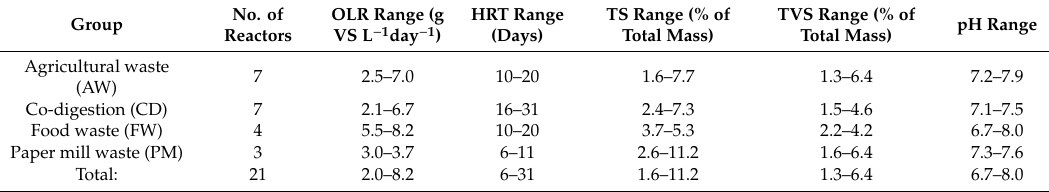
Table 1. Type of feedstocks and operational conditions of sampled laboratory-scale biogas reactors. OLR: organic loading rate; HRT: hydraulic retention times; TS: total solid; TVS: total volatile